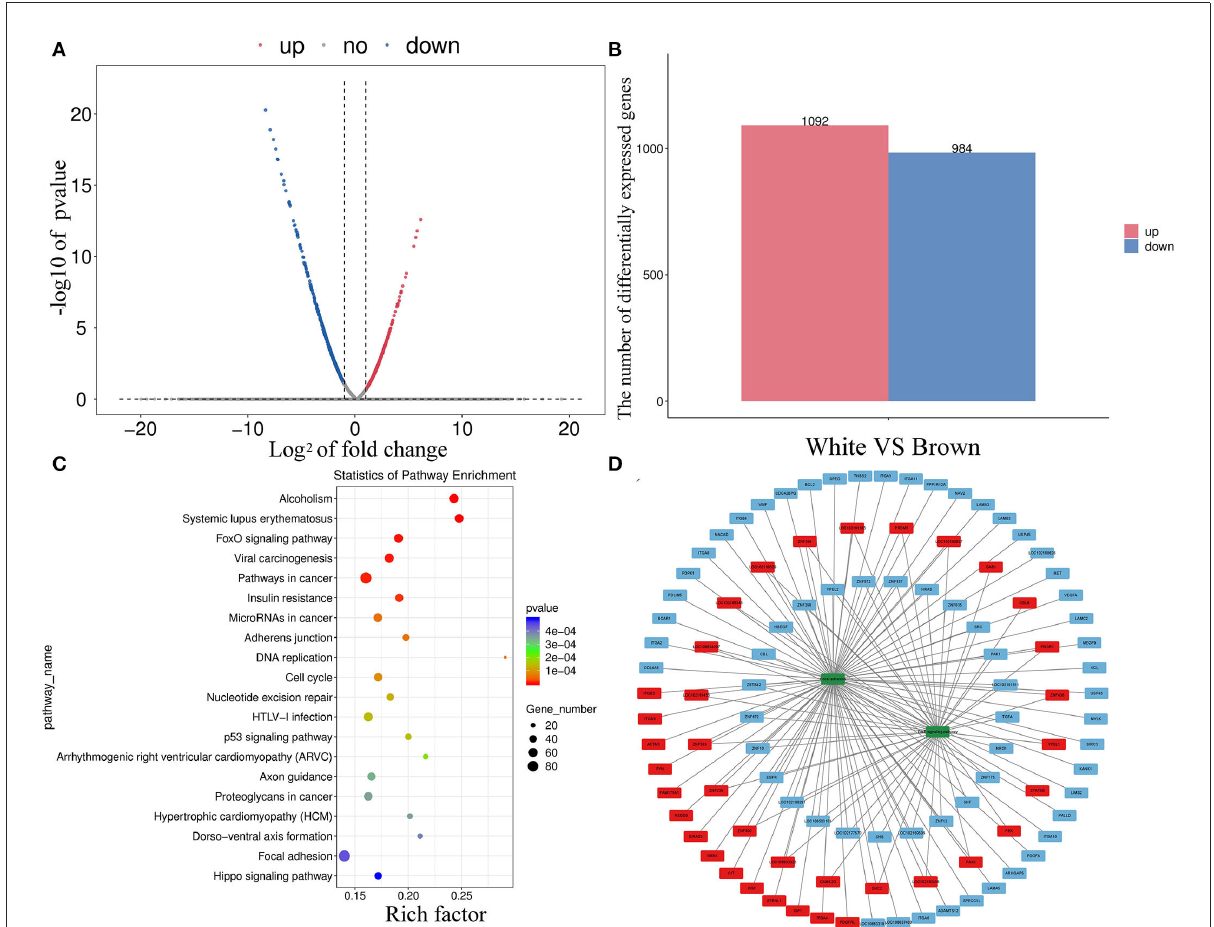
FIGURE4 Divergent expression patterns of mRNAs in melanocytes isolated from Boer goat skins with white and brown hairs. (A,B) Divergent expression patterns of mRNAs in melanocytes. (C,D) DEG annotation results were obtained using the KEGG database; the red symbol marks positive regulatory genes, the blue marks negative regulatory genes, and the green marks key signaling